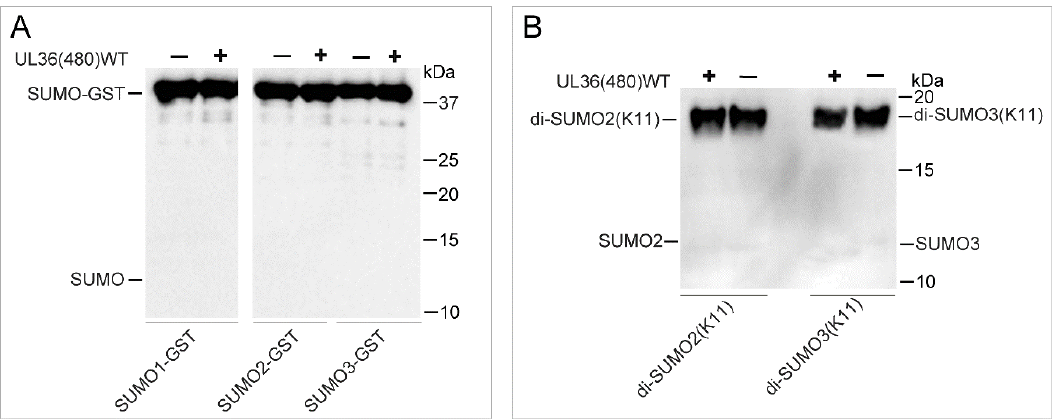
Figure 6. Identification of UL36(480)WT specificity using SUMO substrates. (A) Western blot identification of UL36(480)WT digestion products using substrates SUMO-GST after a 90-min incubation; (B) Western blot identification of UL36(480)WT digestion products using substrates K11 linkage type of di-SUMO2/3 after a 90-min incubation. -, absence of UL36(480)WT in reaction system; +, addition of UL36(480)WT in the reaction system.